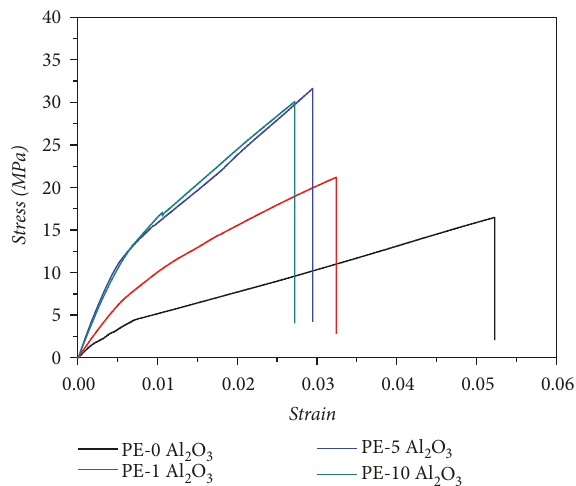
Figure 7: Stress-strain curves of polyester/alumina composites at strain rate of 1x10 −4 /s.